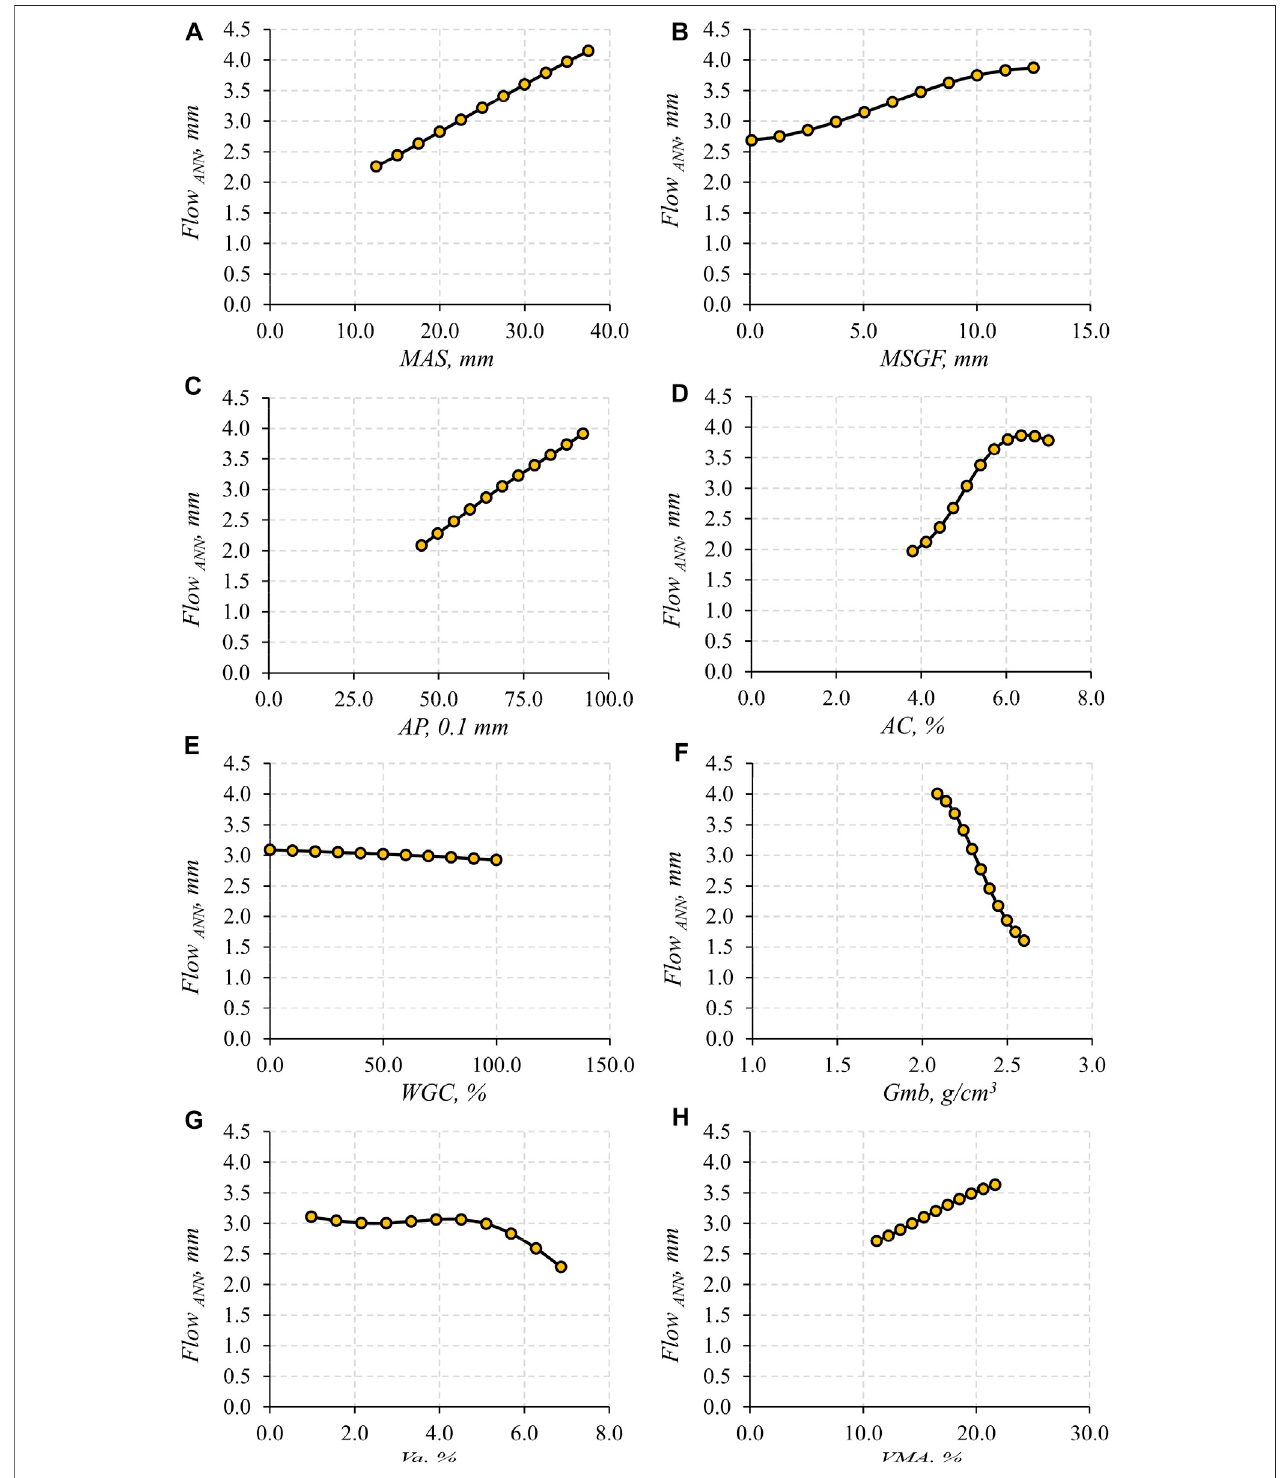
FIGURE 6 | Parametric study for glasphalt fl ow versus (A) Maximum aggregate size (MAS), (B) Maximum size of waste glass fractions (MSGF), (C) Average penetrationgradeofasphalt(AP), (D) Asphaltcontent(AC%), (E) Wasteglasscontent(WGC%), (F) Bulkspeci fi cgravityofglasphaltmixture, (G) Airvoidscontent(Va%), and (H) Voids in mineral aggregate (VMA%).